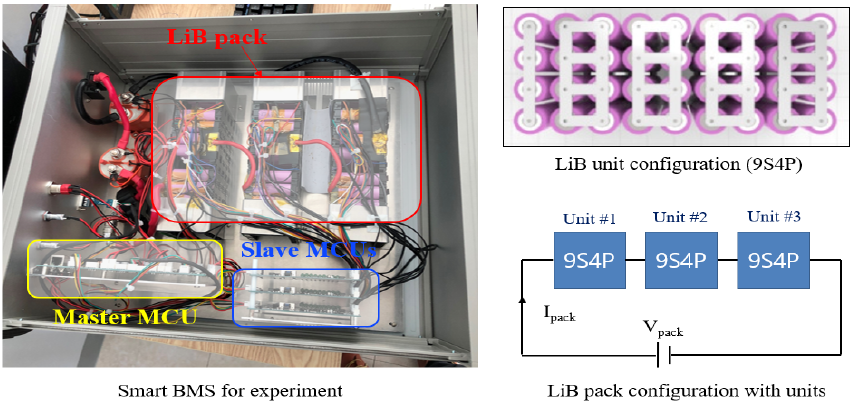
Figure 1. Configurations of the smart BMS and LiB pack.